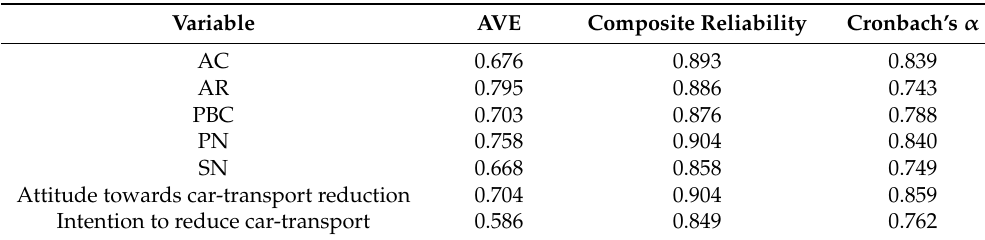
Table 2. Results of Reliability Tests.